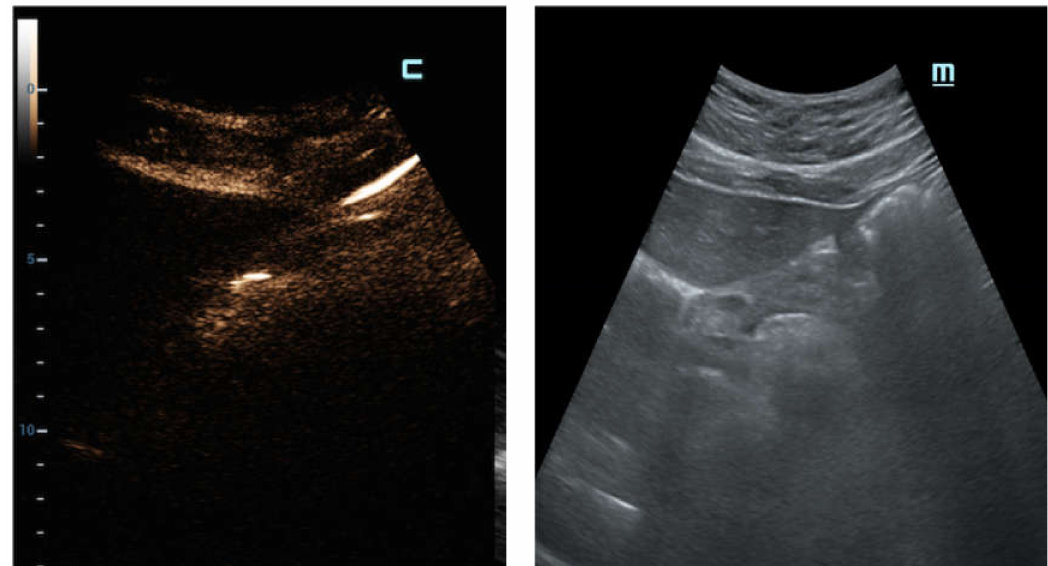
Figure 3. Male patient, 64 years old, surgically treated for GI perforations with finding of gastric foreign body (fish bone). Longitudinal US scan focused on the pre-hepatic space; the C-mode window is automatically displayed when the contrast-specific program is launched. C-mode clearly documents the presence of peritoneal stripes in the pre-hepatic space and around the liver. The visibility of these diagnostic elements is immediately distinguishable on C-mode’s window when compared to B-mode’s image.